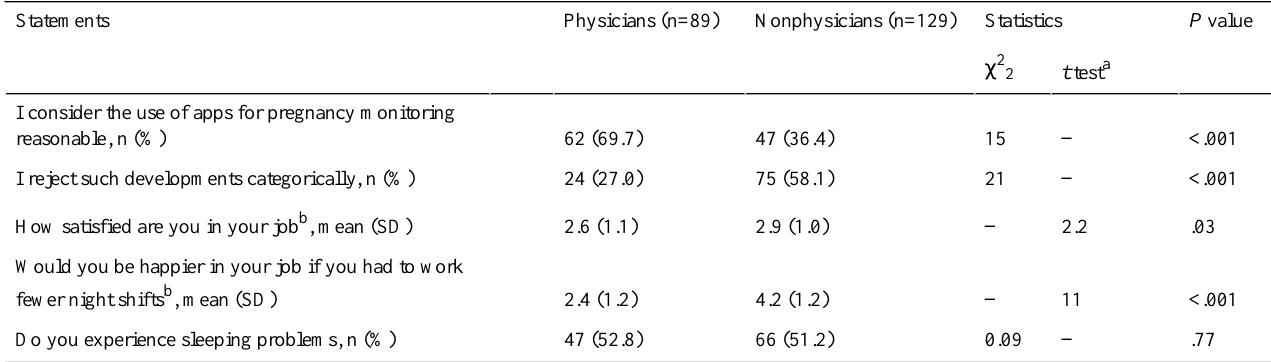
Table 4. Differences in the attitudes between physicians and nonphysicians (N=218).